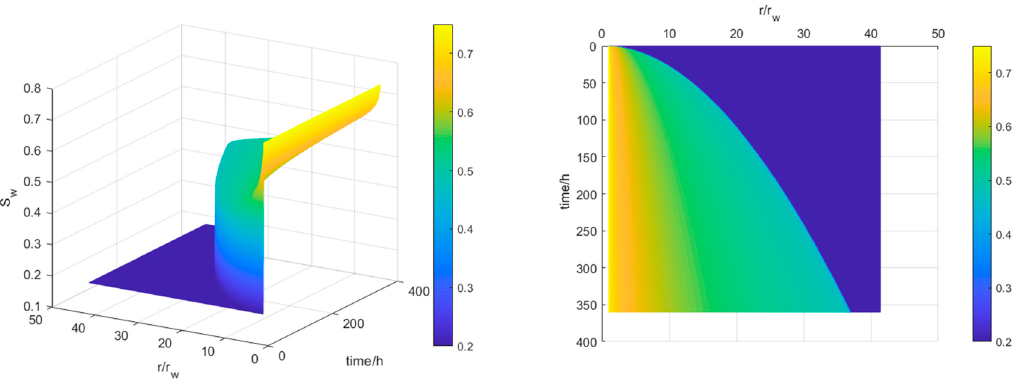
Figure 3. Variation of rock water saturation rate with dimensionless distance and time (3D and 2D).